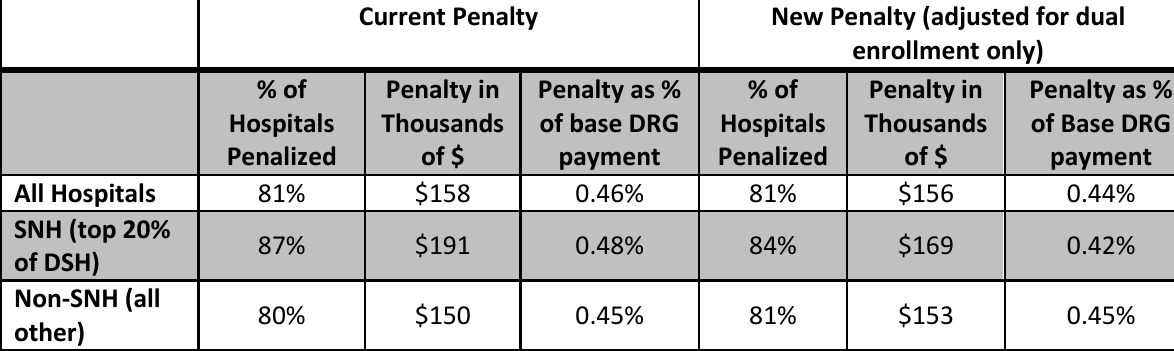
Table 5.8. Results of Adjusting Readmission Rates for Social Risk